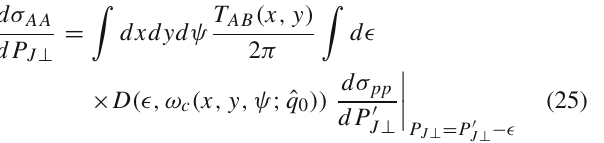
inal BDMPS estimate [5] through our temperature